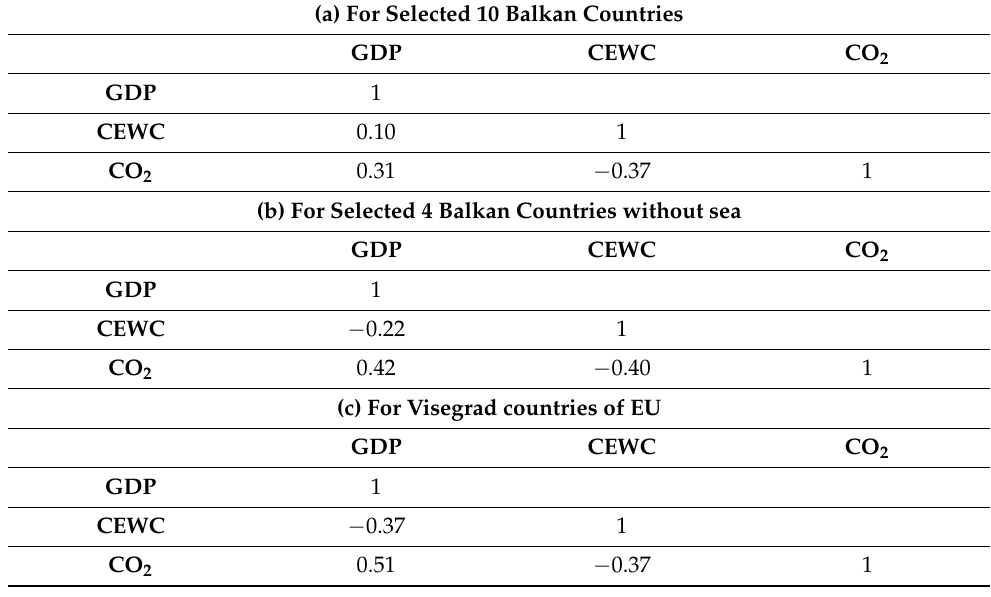
Table 2. Correlation matrix.